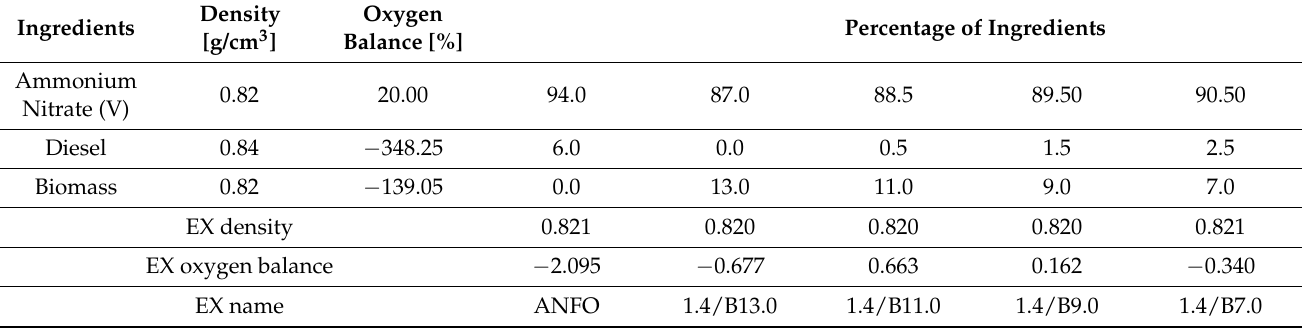
Table 6. Oxygen balance and ANFO-type EX density with the addition of biomass for variant 1.4.